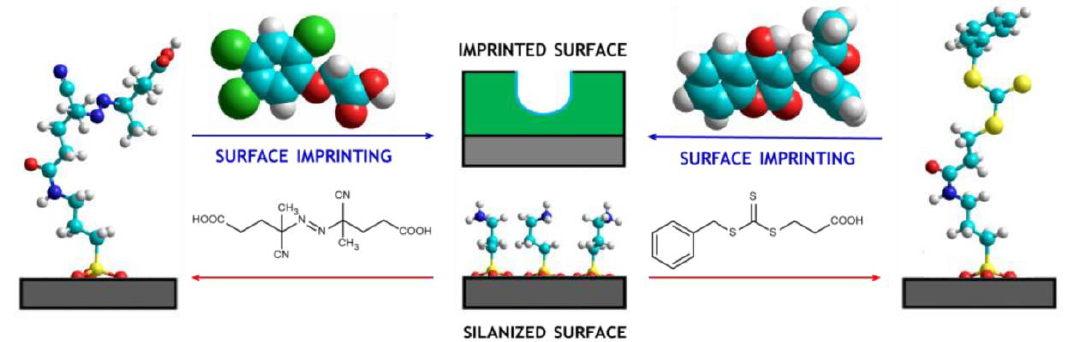
Figure 2. Scheme of the silica surface functionalization by ACVA ( left ) and CEBTTC ( right ) initiators.